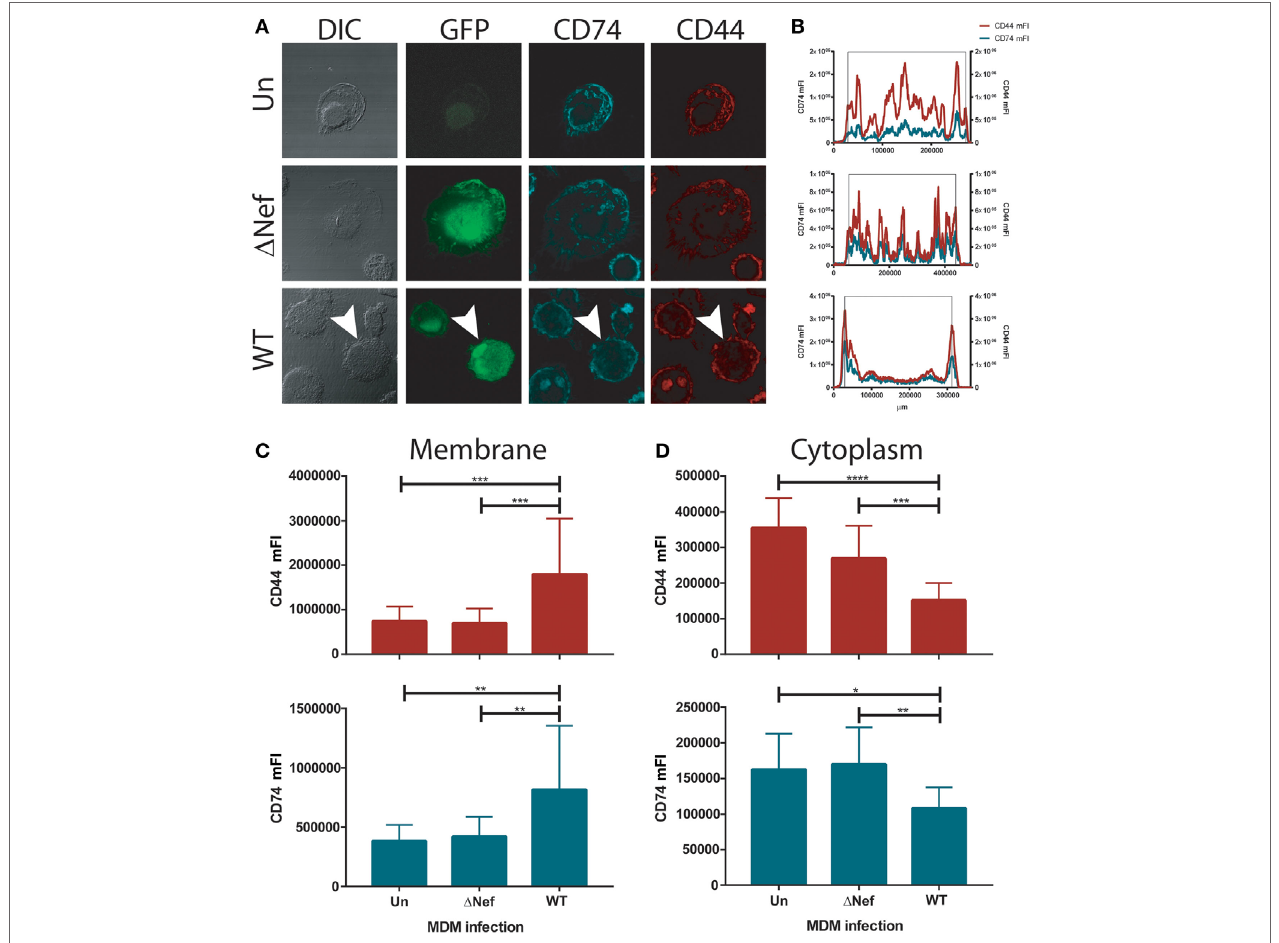
FigUre 2 | CD74 and CD44 expression in uninfected and infected monocyte-derived macrophages (MDMs). (a) Confocal immunofluorescence microscopy of primary uninfected MDMs (UN, upper panels); primary Δ Nef human immunodeficiency virus (HIV)-infected MDMs ( Δ Nef, middle panels); and primary wild type (WT) HIV-infected MDMs (WT, lower panels). From left to right: bright field, GFP (HIV-1 infection), CD74 staining and CD44 staining are shown, in one representative cell for each condition. (B) Plots show cross-sectional mean fluorescence intensity (mFI) for CD74 (left axis, cyan line) and CD44 (right axis, red line) corresponding to the depicted cells (in the lower panel, cross-sectional mFI was evaluated in the cell pointed with an arrow). The black lines indicate the area comprising the cell according to the DIC. (c,D) Cross-sectional mFI quantification for CD44 (upper panel) and CD74 (lower panel) intensity at plasma membrane (c) and cytoplasm (D) . Quantifications were performed in 15 individual cells for each condition. Bars represent mean ± SD. Data were analyzed by one-way ANOVA followed by Dunnett’s post-test. * p < 0.05, ** p < 0.01, *** p < 0.001, **** p <